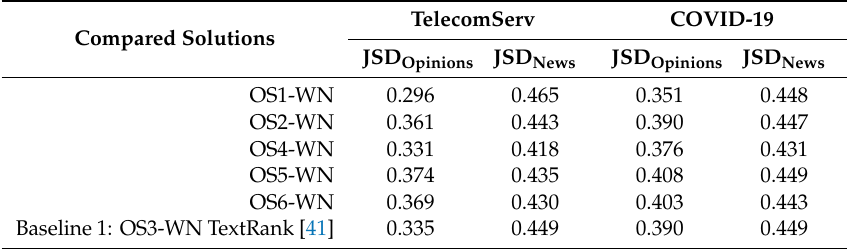
Table3. Summaryofaveragedresultsofthe JSD News and JSD Opinions metricsconsideringWordNet-based semantic processing.